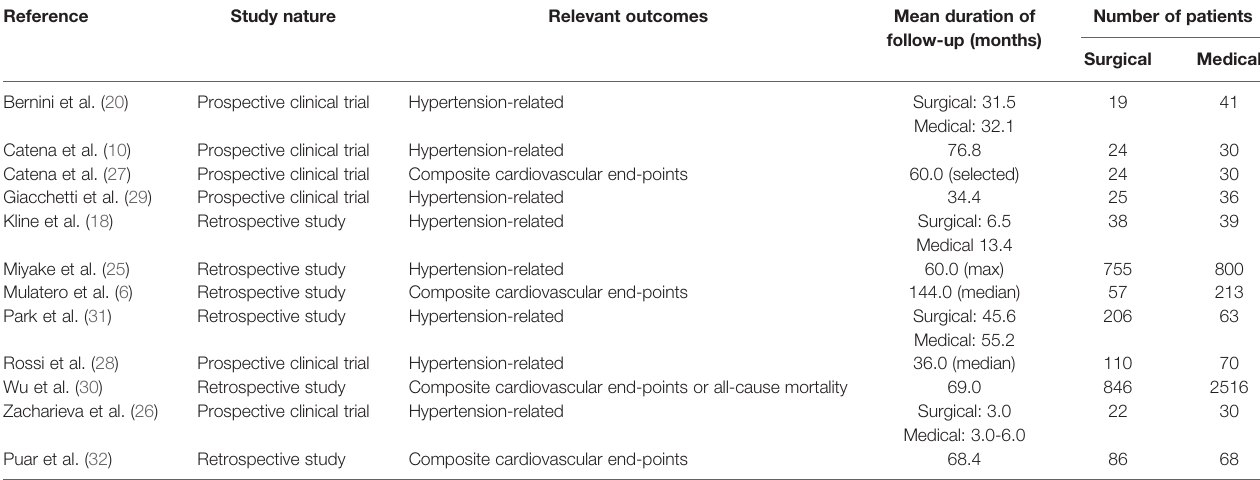
TABLE 1 | Characteristics of the trials included in the